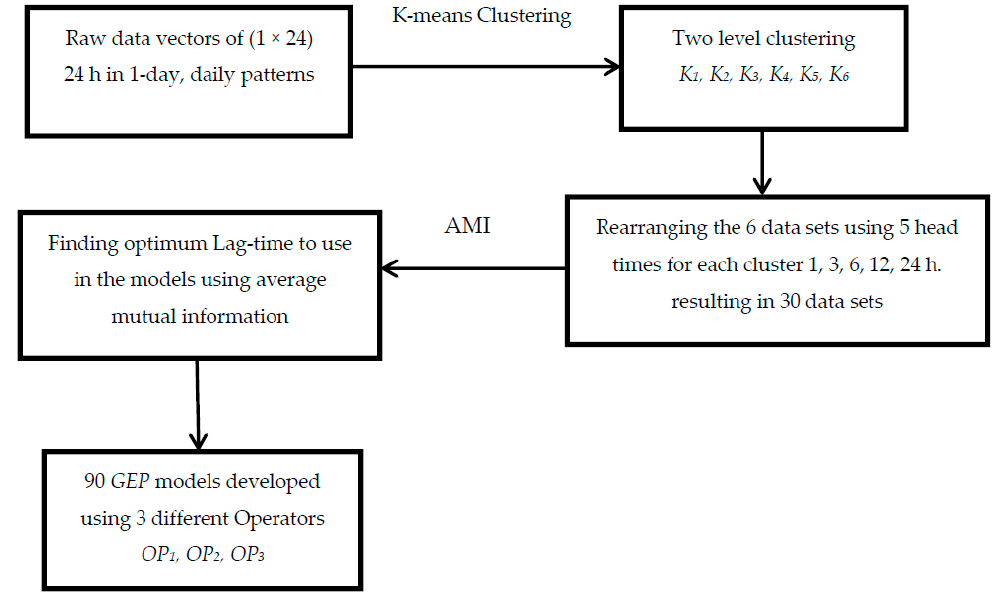
Figure 1 . Schematic of the proposed approach. Figure 1. Schematic of the proposed